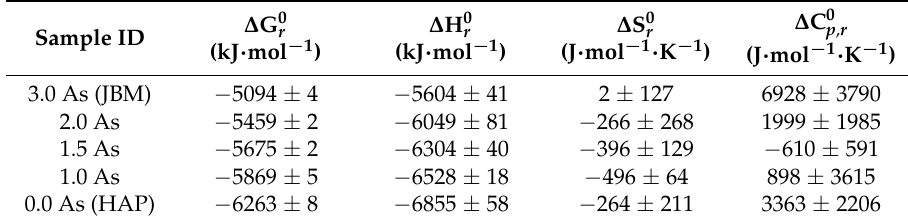
Table 8. Standard thermodynamic functions of formation determined experimentally for JBM–HAP solid solution series (temperature T of 298.15 K and pressure p of 0.1